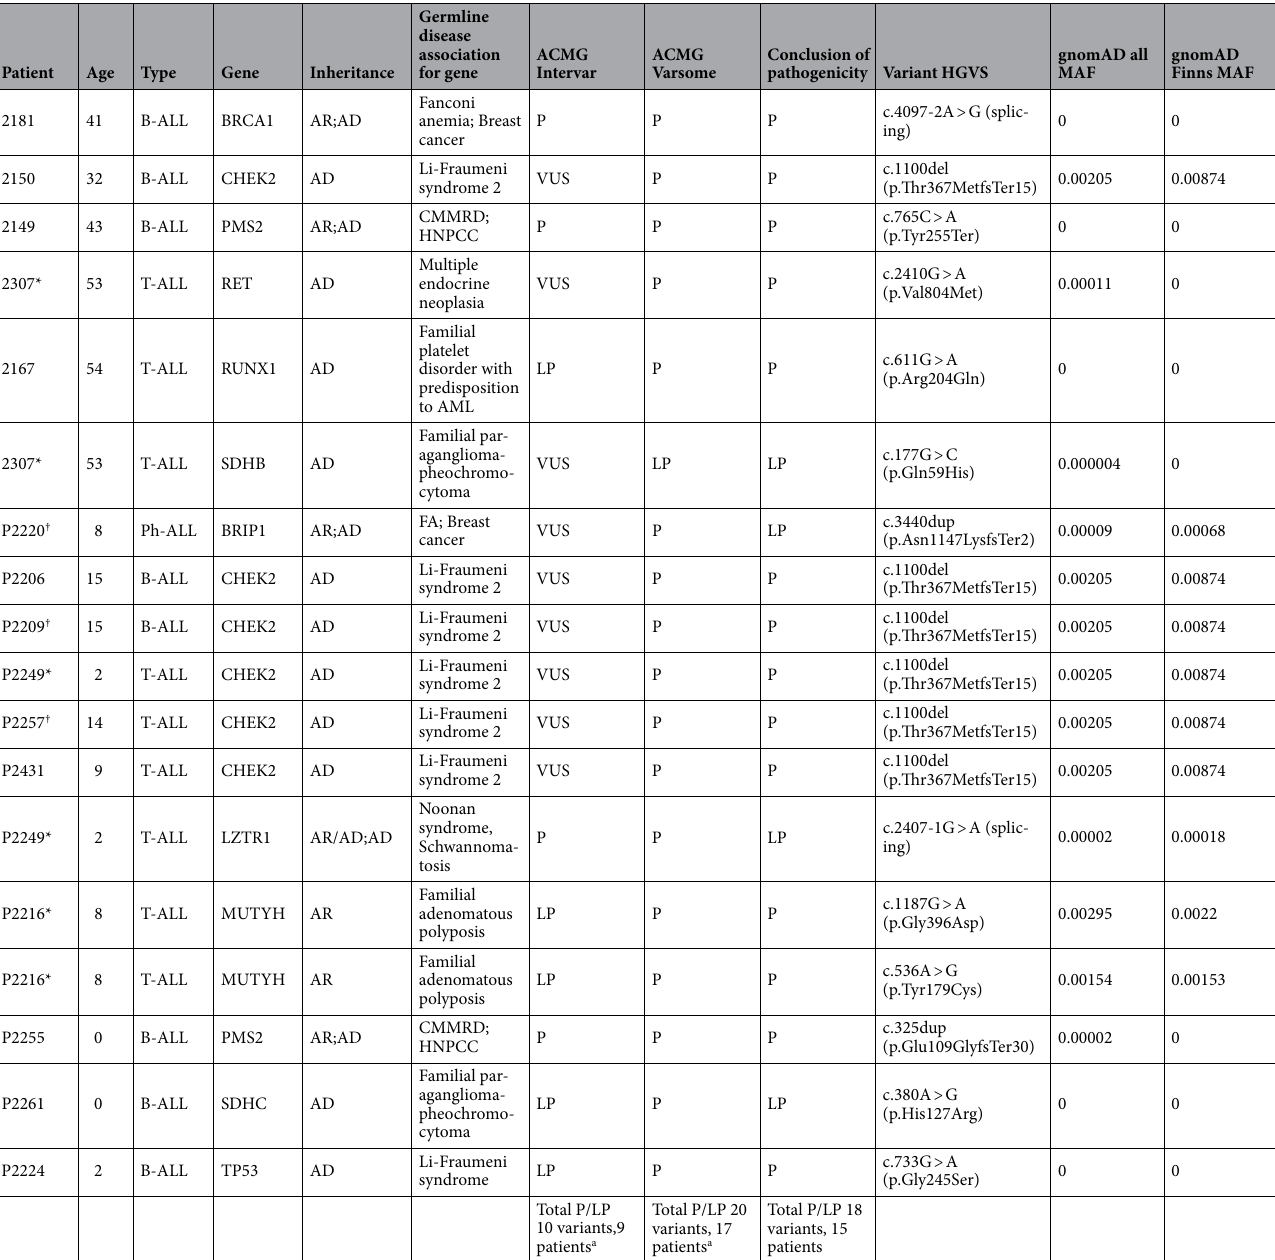
Table 2. Pathogenic/likely pathogenic variants in autosomal dominant genes or compound heterozygous variants in recessive genes. ACMG, American College of Medical Genetics; AD, autosomal dominant; AML, acute myeloid leukemia; AR, autosomal recessive; B-ALL, Ph-negative B-ALL; Ph-ALL, Ph-positive B-ALL; CMMRD, constitutional mismatch repair deficiency; FA, Fanconi anemia; HNPCC, hereditary non-polyposis colorectal cancer; LP, likely pathogenic; MAF, minor allele frequency; P, pathogenic; VUS, variant of uncertain significance. *Patients with multiple P/LP variants. † Samples with a high blast percentage. a All variants classified P/LP by Intervar and Varsome not shown here. Pediatric patients are marked with a